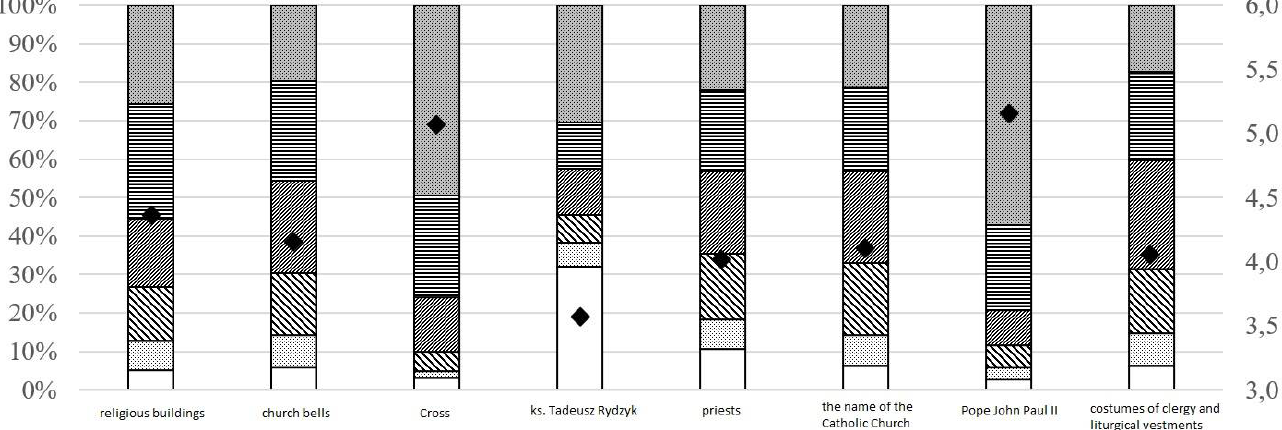
Figure 9. Branding characteristics of the Catholic Church in Poland. Source: authors’ own elaboration.